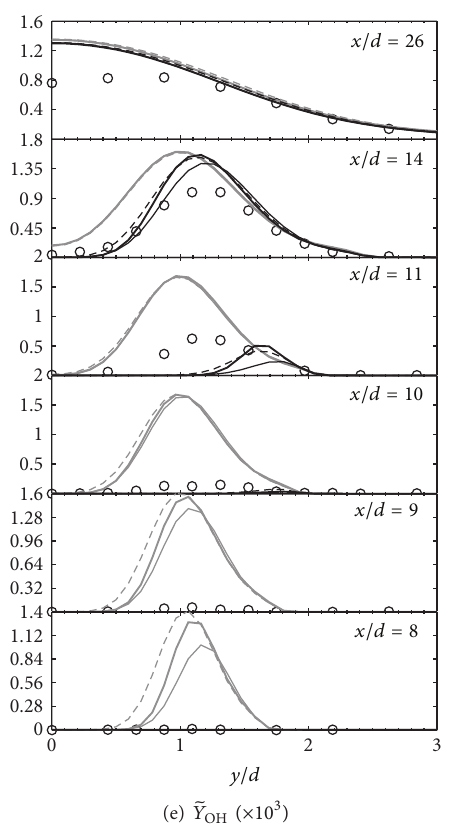
̃𝑇 ̃𝑌 ̃𝑌 (× 10 2 ) , (d) ̃𝑌 (× 10 2 ) , and (e) ̃𝑌 (× 10 3 ) obtained from the three CMC realisations , (b) , (c) O 2 H 2 H 2 O OH